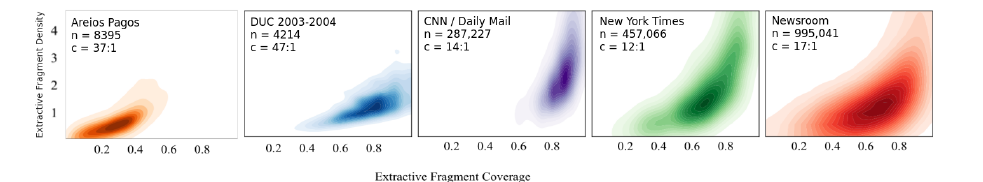
Figure 2. A comparison of the extractive fragment coverage - extractive fragment density relationship for the AreiosPagos dataset compared to other text summarization datasets. Data observations are plotted using a kernel density estimate method. n denotes the number of documents in the dataset, and c refers to the compression ratio of the main text’s length over the summary’s length. Leftmost: the AreiosPagos dataset. Right: news domain datasets as reported in [17]. The AreiosPagos dataset is homogeneous in terms of coverage, as a moderate percentage of words in the summary appear also in the main text. In terms of extractive fragment density, the AreiosPagos dataset shows less variance than the other datasets, while having generally low